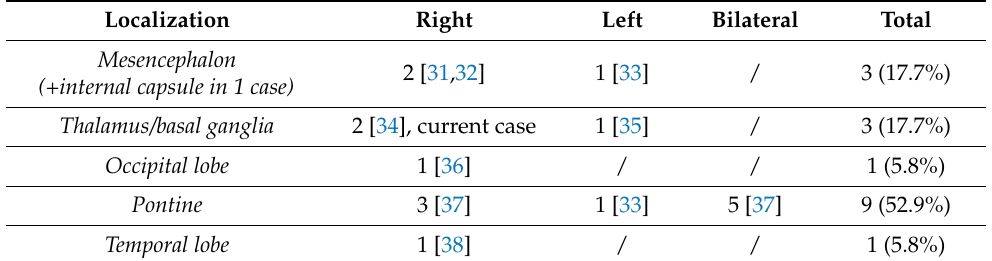
Table 1. Distribution of the lesions in cases of intracerebral hemorrhage-related peduncular halluci- nosis ( n =